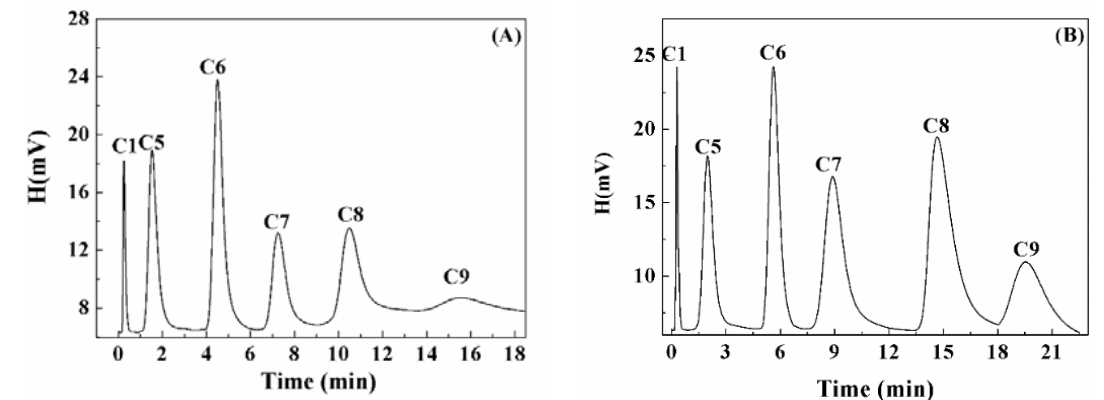
Figure 5. Chromatograms of CH 4 + C 5 –C 9 mixture in ( A ) volcanic glass and ( B ) Cu 2+ -volcanic glass. T C = 400 K + 5 K/min.